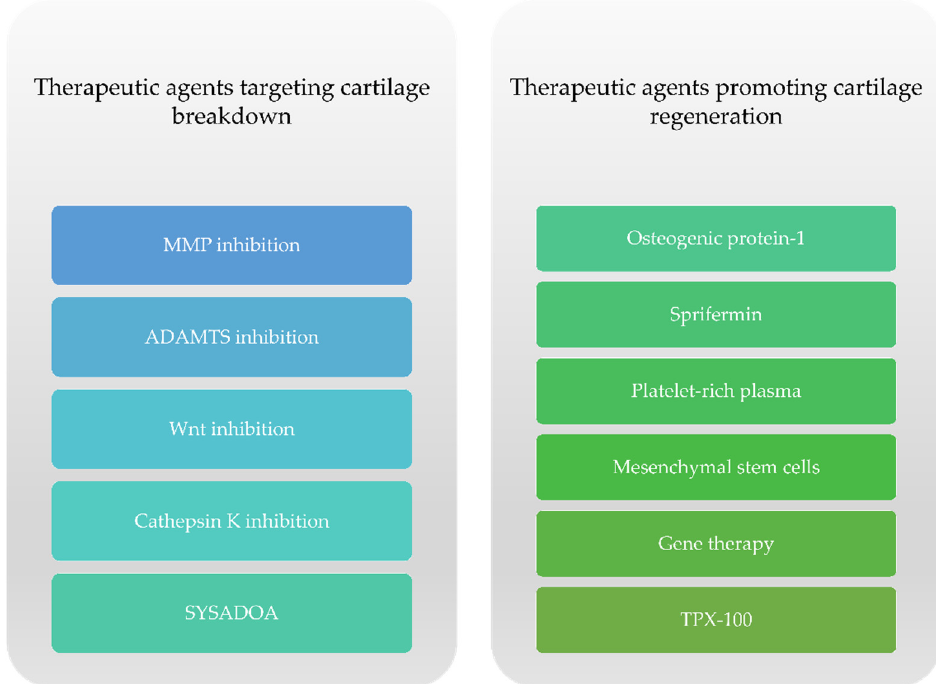
Figure 2. Therapeutic options targeting cartilage damage in knee OA.